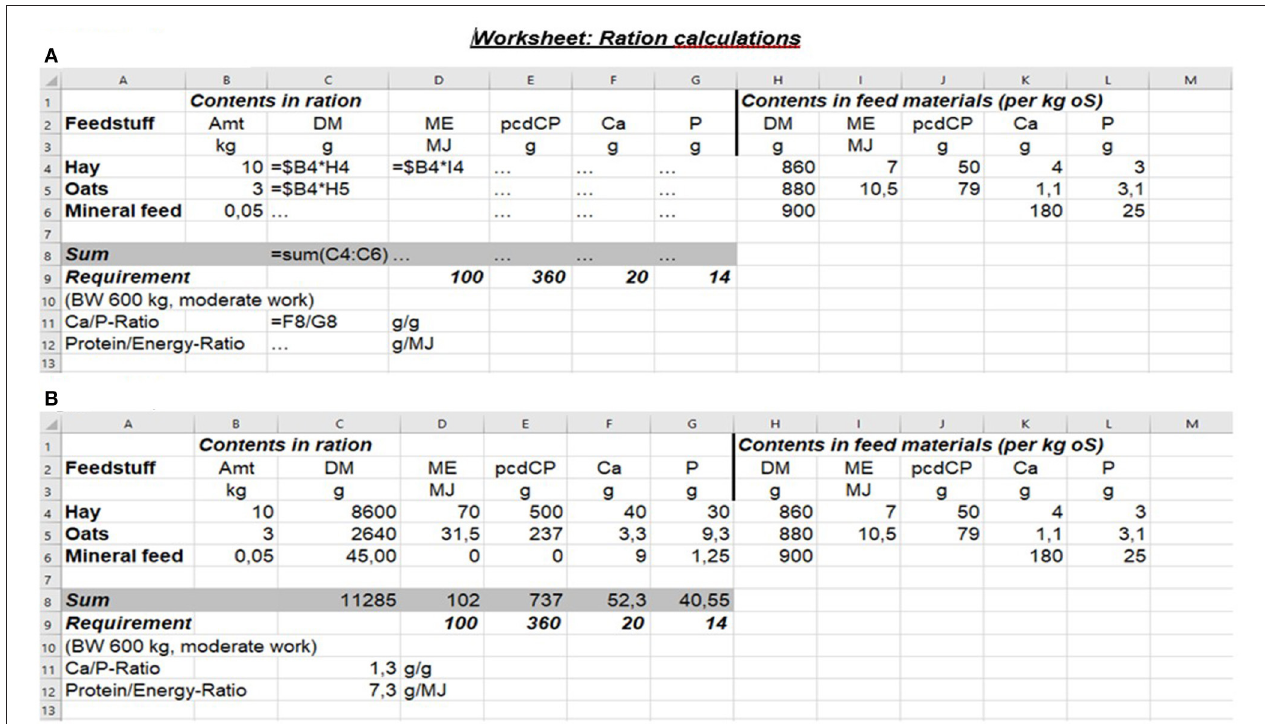
FIGURE 1 | Template for ration calculation for horses in MS EXCEL TM with (A) the formulas shown in the cells and (B) the finished calculation for an example